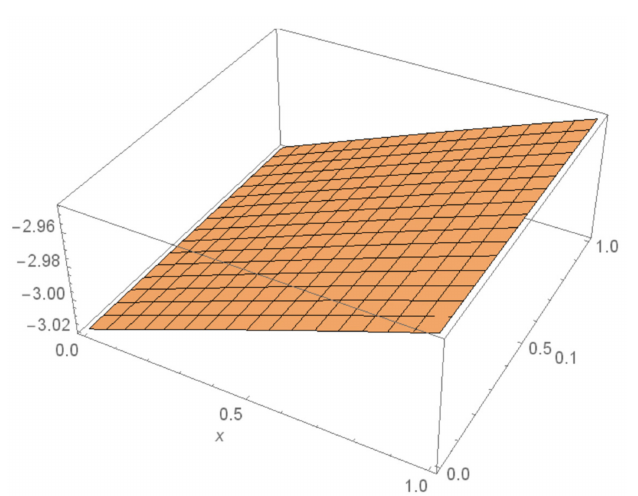
Figure 4. 3D plot of exact solution of g ( η , t )